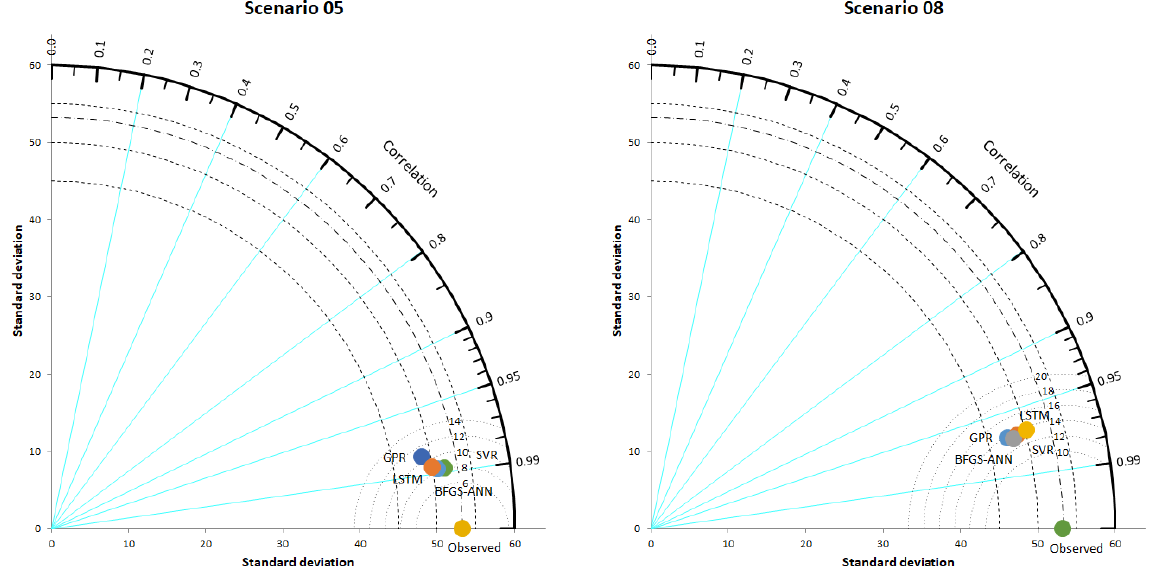
Figure 12. Taylor diagrams of scenarios 5 and